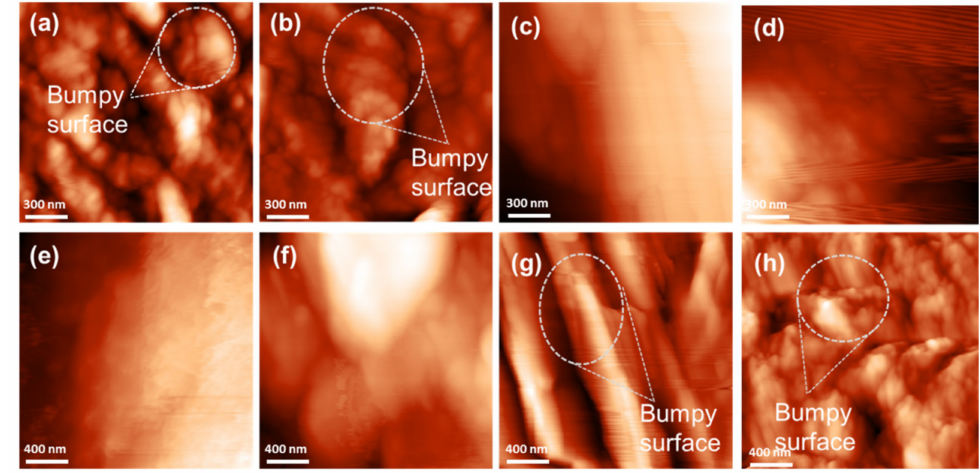
Figure 9. AFM topography at 2 µ m × 2 µ m ( a ) PCMD5, ( b ) PCMW5, ( c ) PCMD10, ( d ) PCMW10, ( e ) PCMD15, ( f ) PCMW15, ( g ) PCMD20, and ( h )